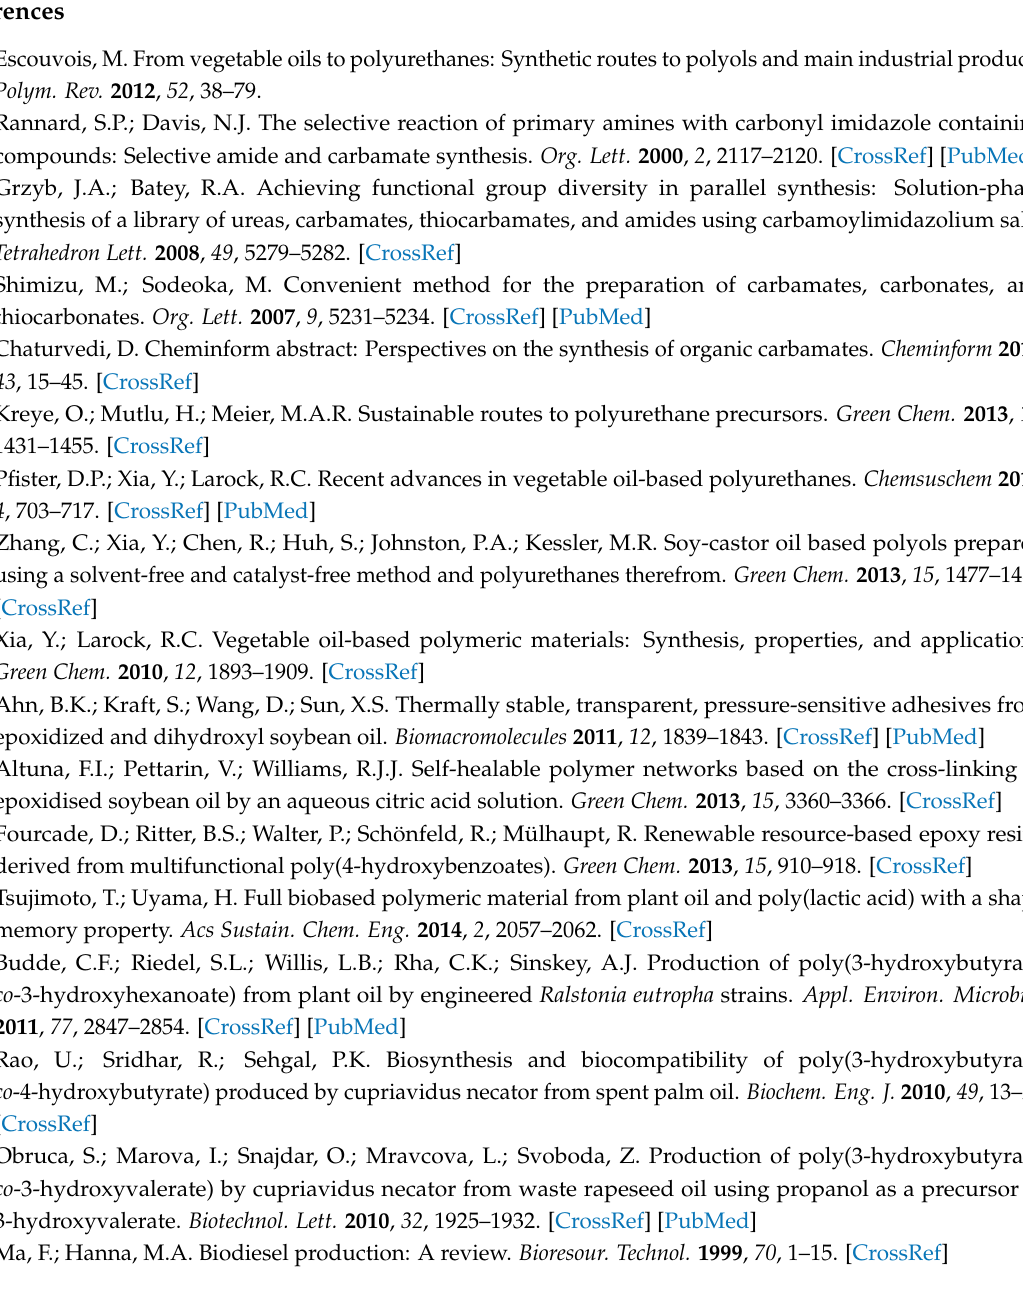
Figure S1: FTIR spectra of castor oil and amide diols; Figure S2: FTIR spectra of CPUs; Figure S3: DSC curves of